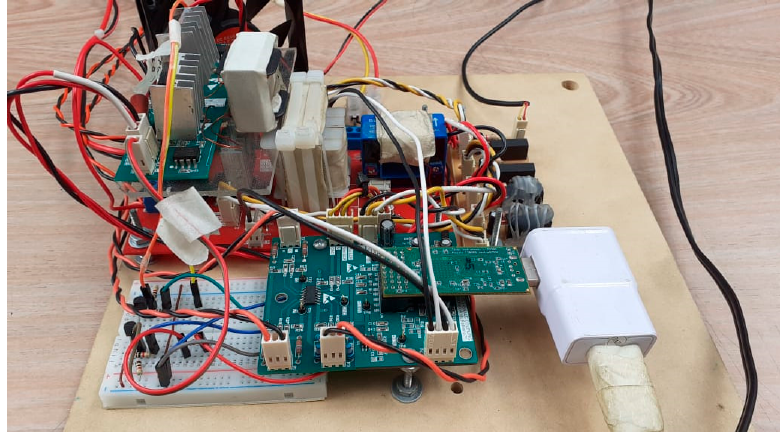
Figure 19. Prototype of the voltage doubler boost